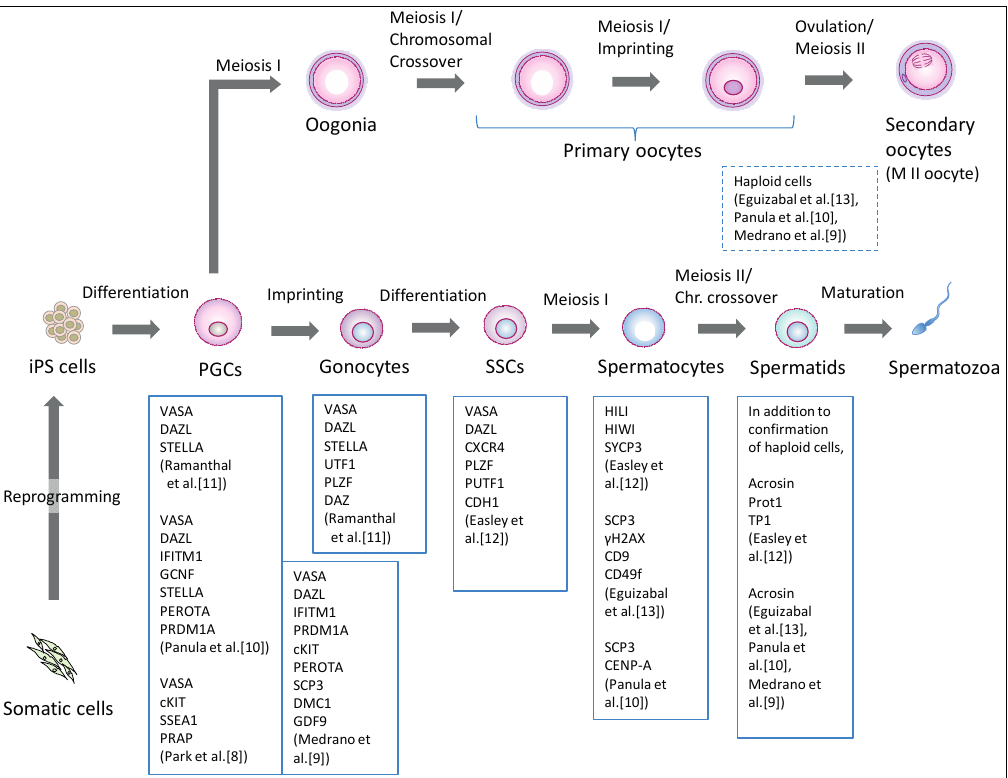
Figure 2. Differentiation pathway from human iPS cells to germ cells. Human iPS cells are differentiated into primordial germ cells (PGCs), and further differentiated into meiotic cells. Indicated information regarding confirmed markers is derived from research reports regarding germ cell induction using human iPS cells. PGCs: primordial germ cells, SSCs: spermatogonial stem